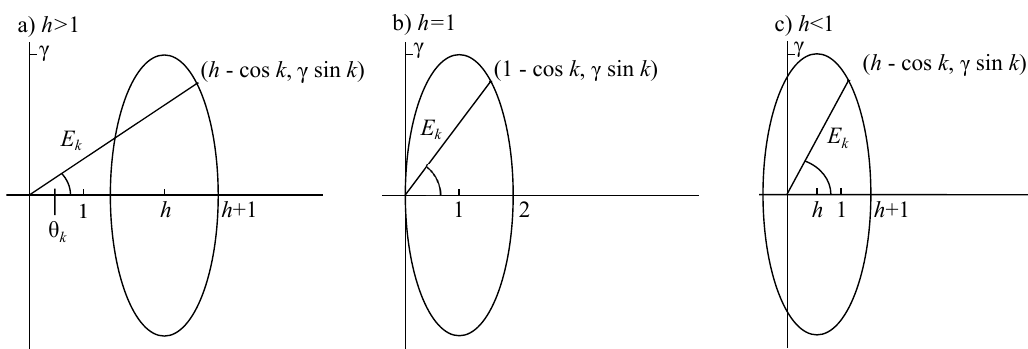
Figure 1: Ellipse representation of the anisotropic TFIM ground state. Note that the ellipse is parametrized counterclockwise whenever γ > 0. The winding number | θ − θ | /π determines if the Hamiltonian is in the paramagnetic or ferromagnetic π 0